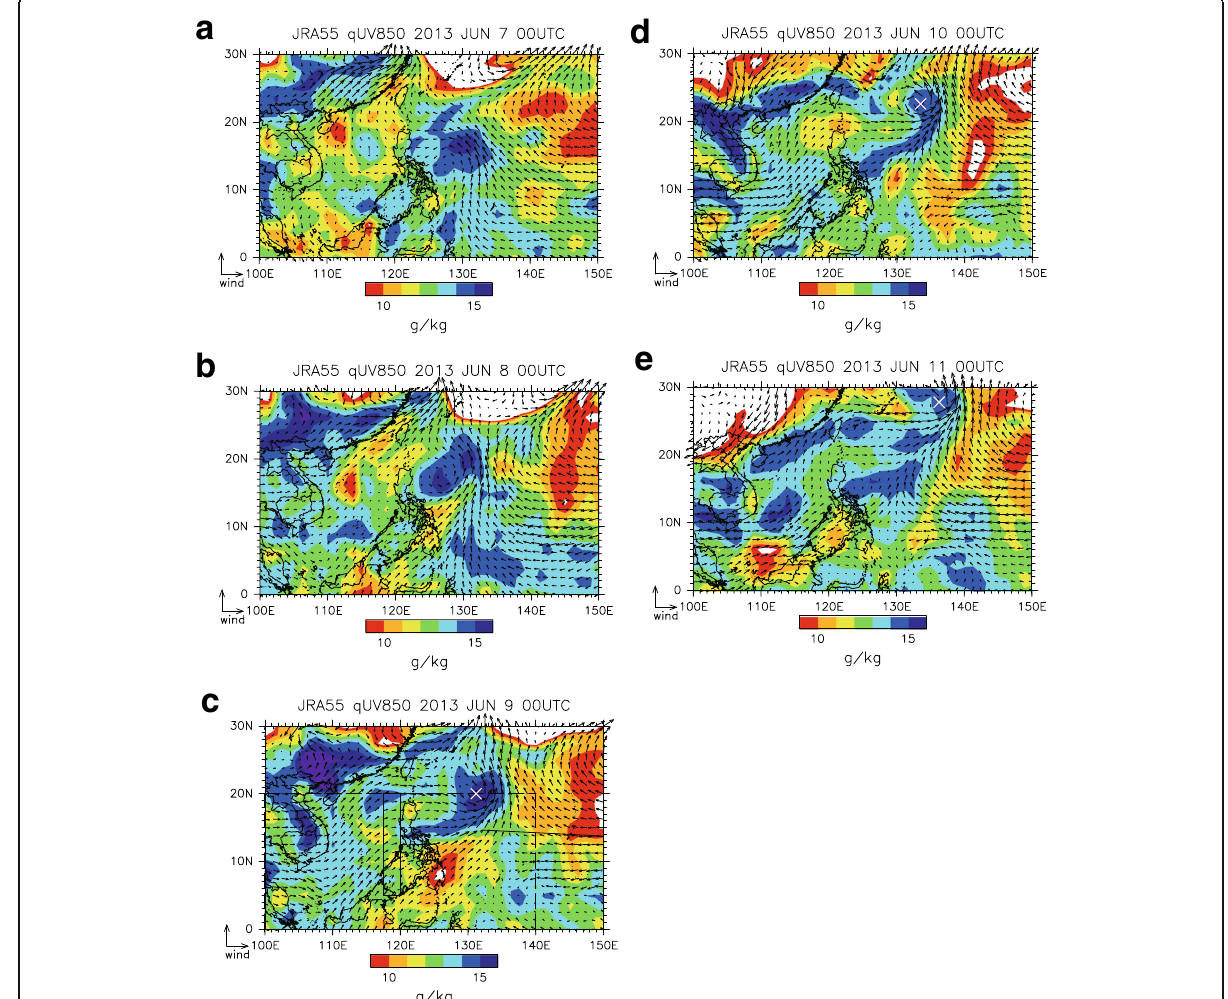
Fig. 10 Horizontal structure of water vapor mixing ratio (shading; g/kg) and wind (vector) at 850 hPa from June 7 ( a ) to 11 ( e ), 2013. Unit vectors represent 25.0 m/s. Crosses indicate the centers of a tropical storm. Solid and dashed boxes in c are the cross-sectional area used in Fig. 9 and the area used to calculate